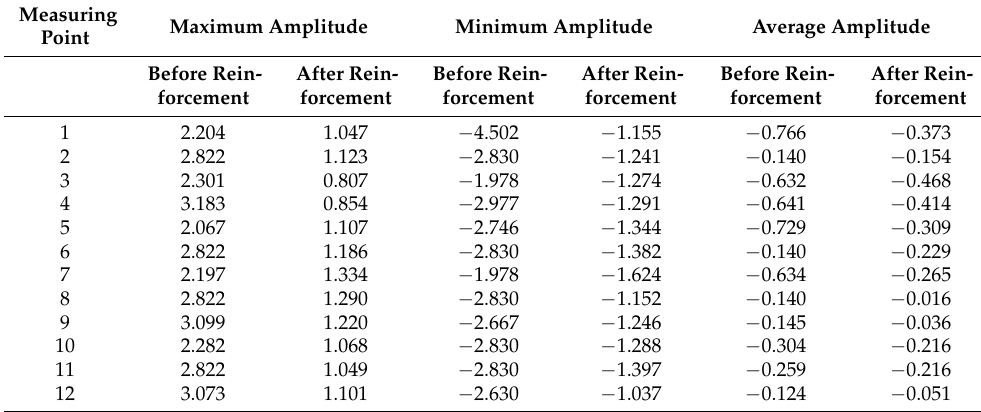
Table 2. Maximum amplitude of deck before and after reinforcement (unit: mm).